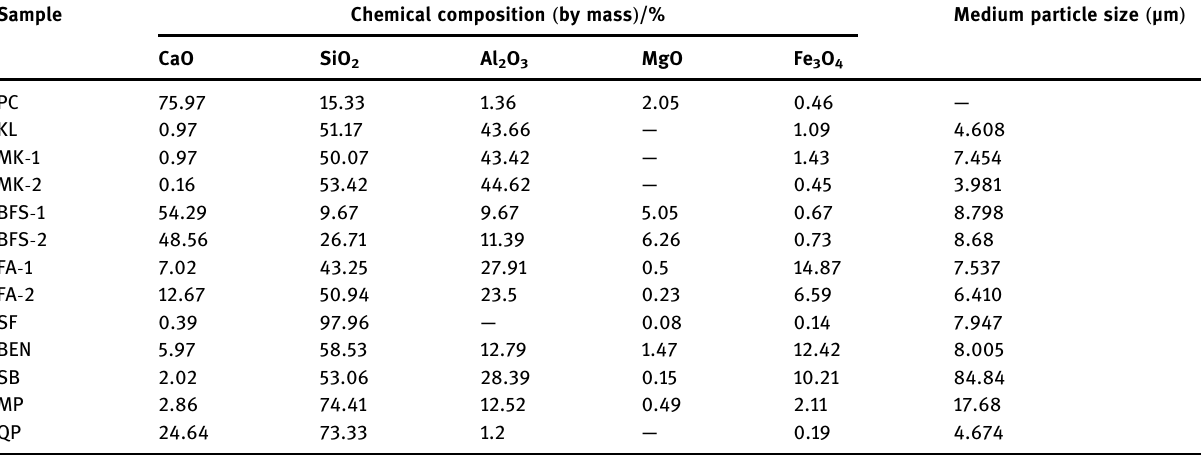
Table 1: Chemical composition of raw materials Sample Chemical composition ( by mass ) /%